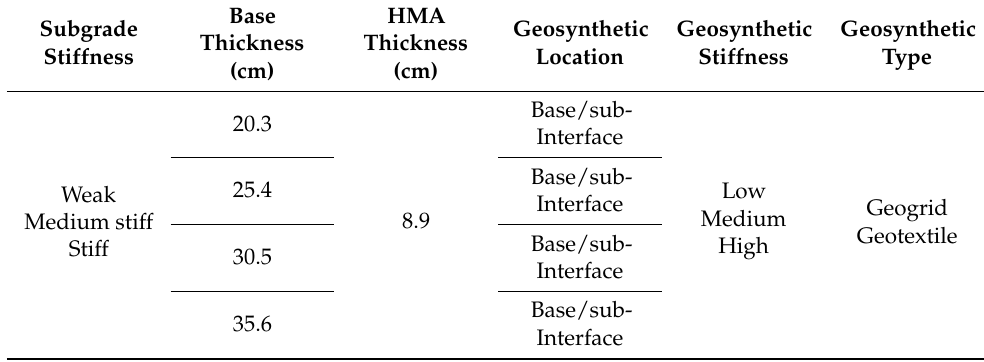
Table 6. Parametric study.